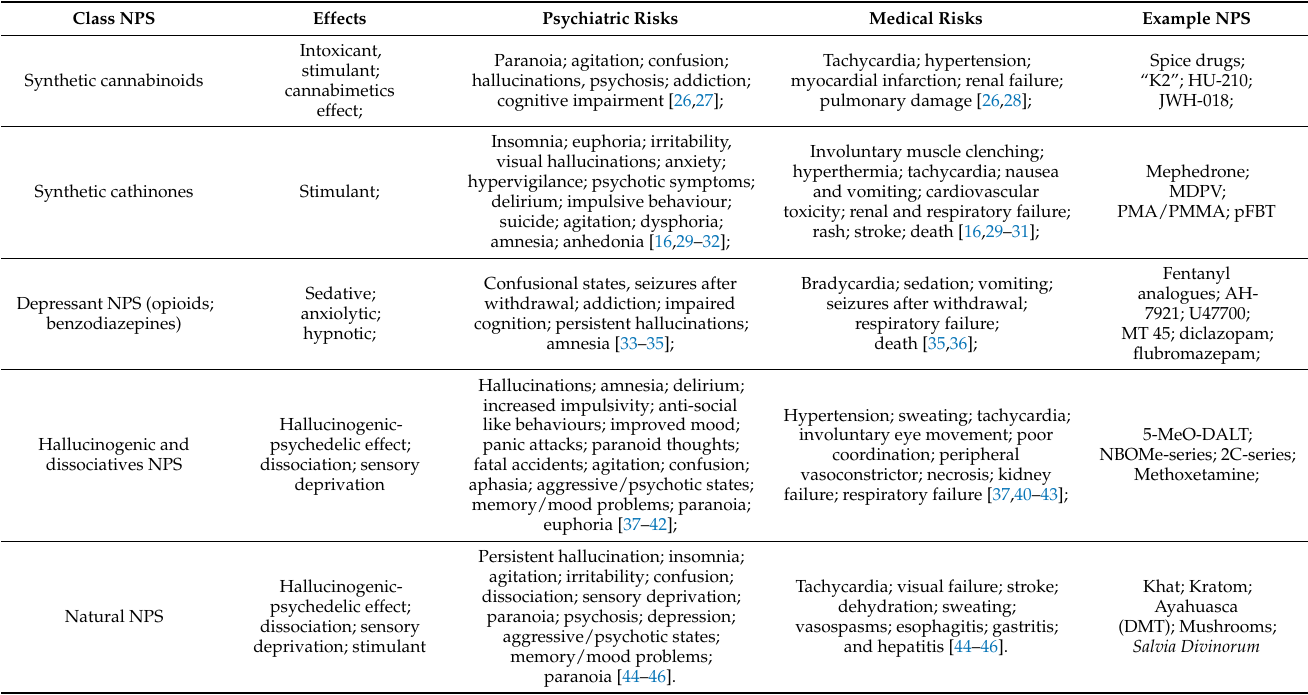
Table 1. Novel psychoactive substances (NPS) and their